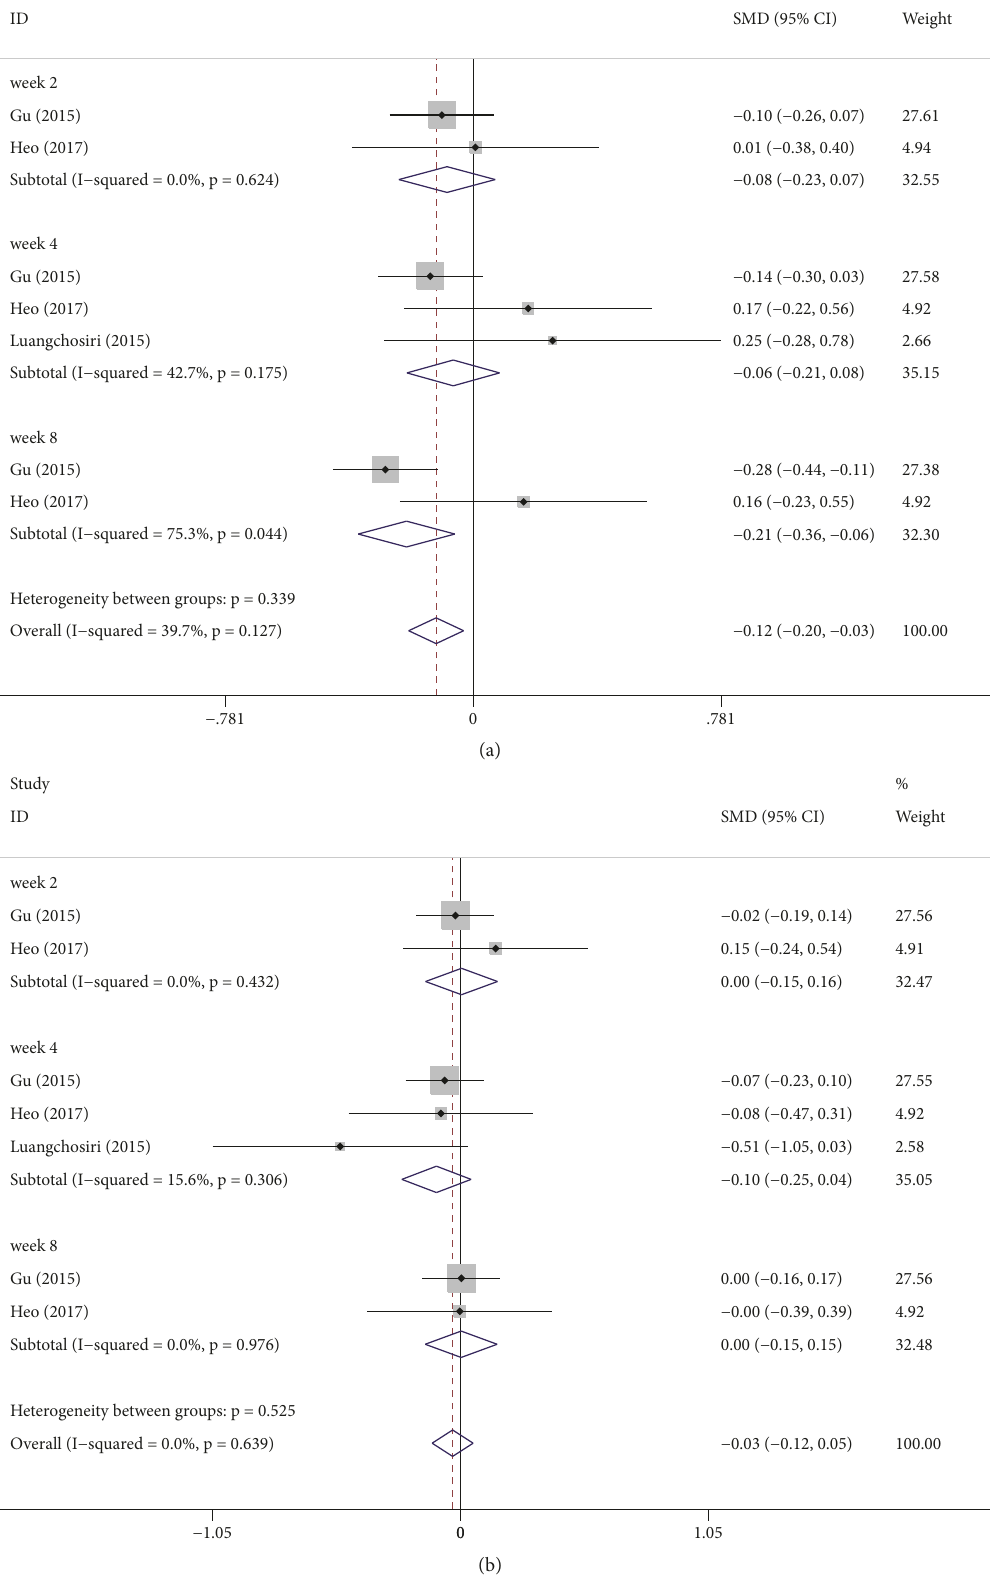
Figure 4: Effect of silymarin on changes in the liver function tests. (a) Alkaline phosphatase (ALP). (b) Total bilirubin